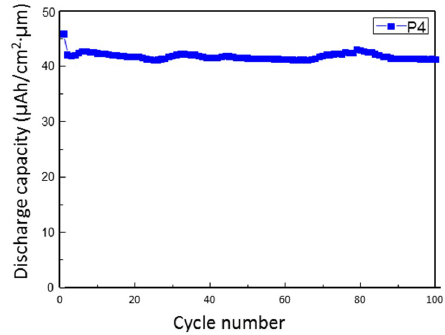
Figure 3. Cycling performance of the P4 thin film.